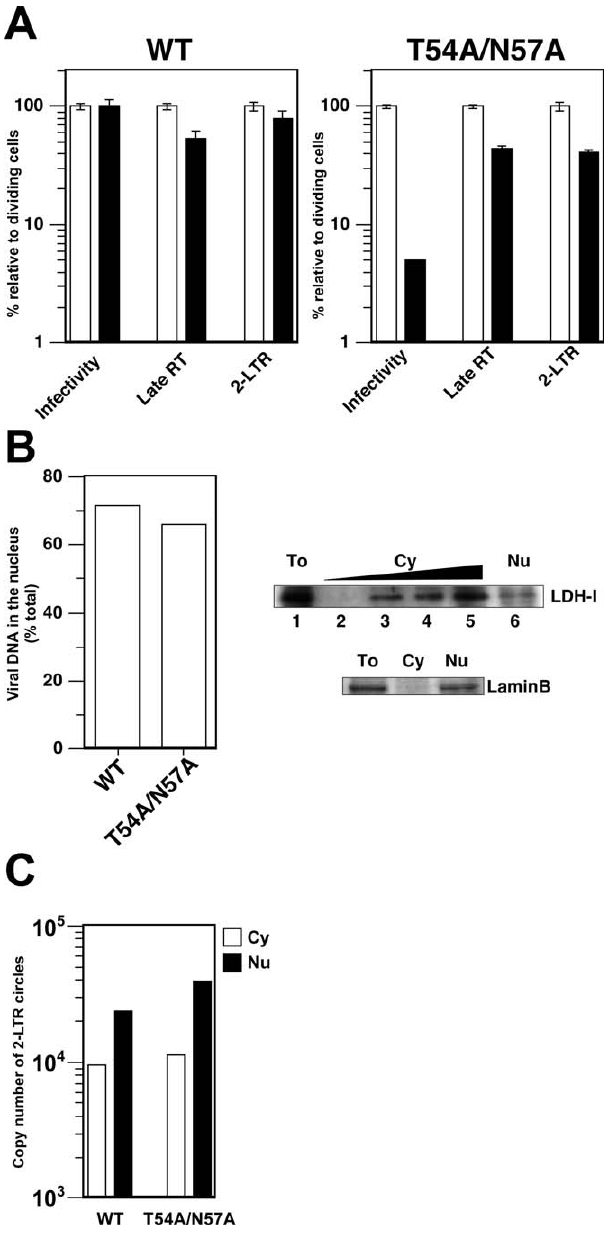
Figure 3. Reverse Transcription and Nuclear Import of Viral DNA in Nondividing Cells (A) Viral DNA synthesis and formation of 2-LTR circles. Dividing (shown in white bars) and nondividing HeLa cells (shown in black bars) prepared by aphidicolin treatment were infected with reporter virus constructs bearing the WT CA or T54A/N57A mutation. Virus infectivity was assessed by quantifying GFP-positive cells 2 d after infection. Relative infectivity is shown as percentage of infectivity in dividing cells. Total DNA was extracted 1 d after infection and used in real-time PCR to measure the copy number of late products of reverse transcription (RT) as well as that of 2-LTR circles. The data is shown as relative values where the amount in dividing cells for each different virus is set at 100%. Infections were done in triplicate and error bars indicate standard deviation. Two independent experiments were performed with similar results. One representative experiment is shown here. (B) Nuclear localization of viral DNA. Nondividing cells infected with either WT HIV-1 or the CA mutant T54A/N57A were separated into cytoplasmic and nuclear fractions (left panel). DNA extracted from each fraction was used as template for real-time PCR to measure newly synthesized viral DNA. The efficiency of nuclear migration of viral